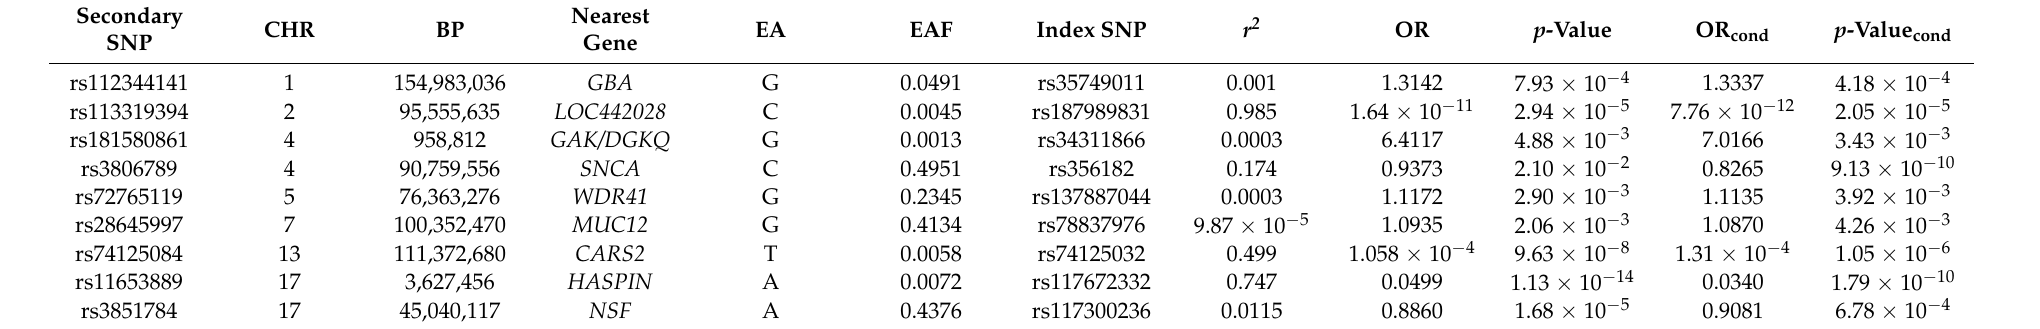
Table 3. Secondary association signals from conditional